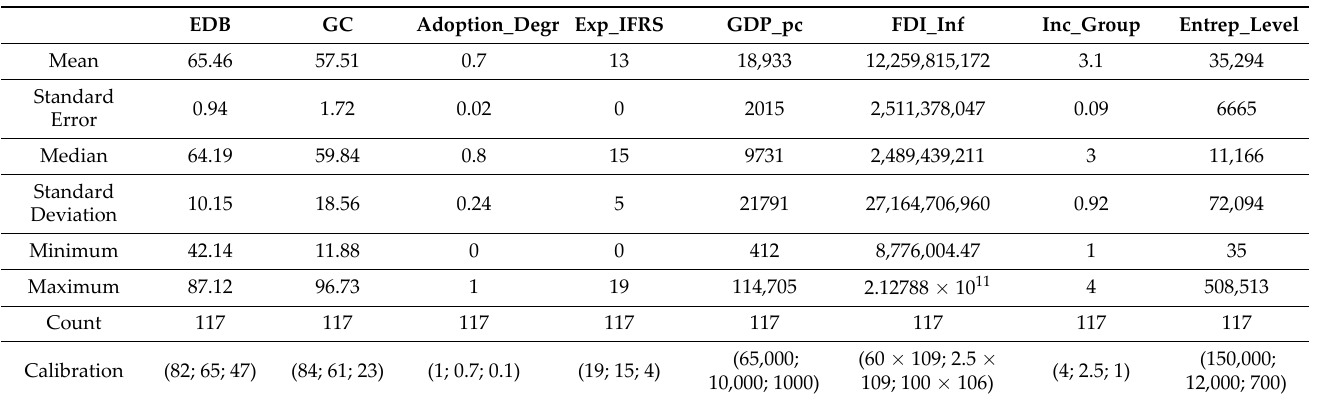
Table 5. Sample descriptive